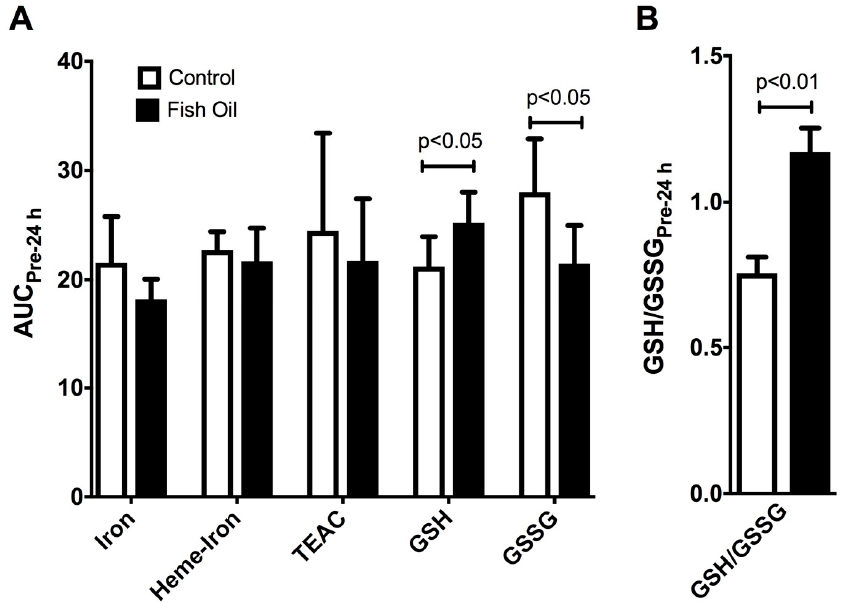
Figure 4. Effect of fish oil supplementation on redox parameters in response to a single bout of strength exercise after 6 weeks of daily undulating strength training (post-training period). Results presented as mean ± S.E.M. ( A ) Areas under curves (AUC) were calculated to express total concen- trations of oxidative stress biomarkers in plasma pre- and 24 h post-exercise; ( B ) Reduced/oxidized glutathione ratios (GSH/GSSG) pre- and 24 h post-exercise.